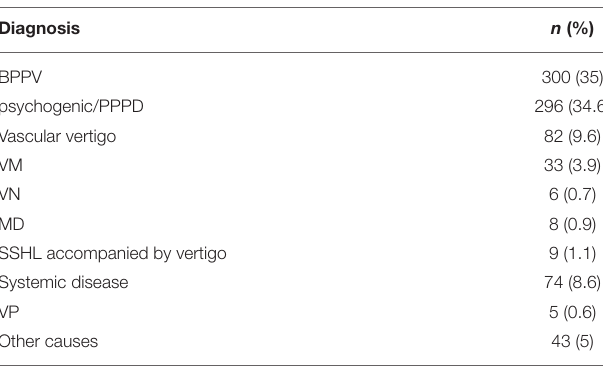
TABLE 1 | The etiologic distribution of 856 dizziness/vertigo patients during the COVID-19 epidemic.